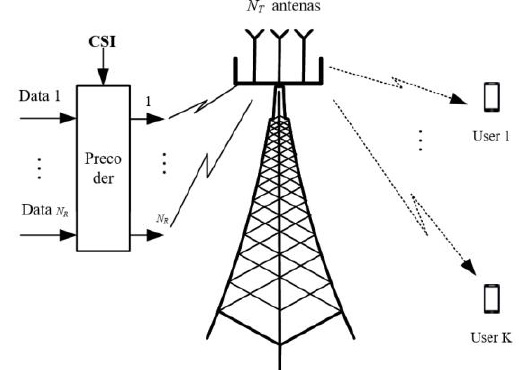
Fig. 1. The downlink channel model in MU-MIMO